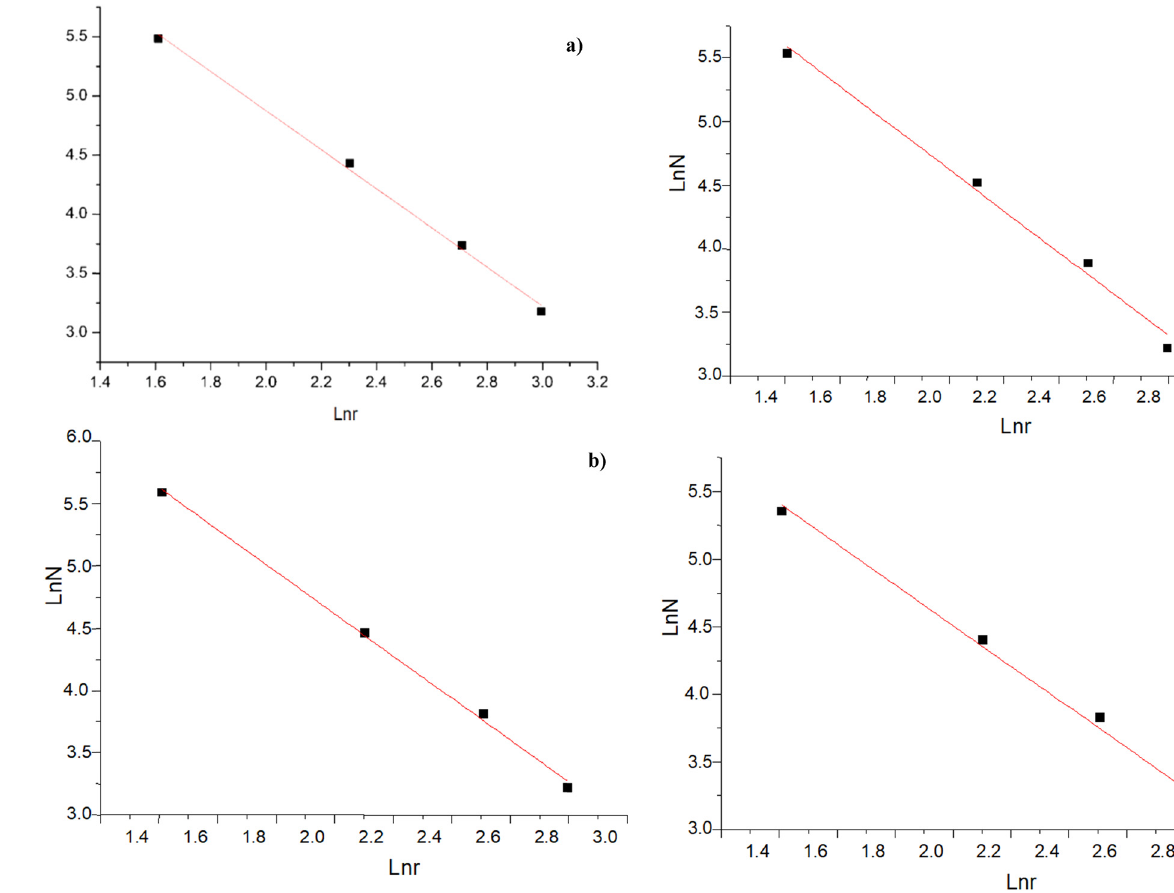
Figure 18: Double logarithmic fi tting of Type II ( a ) and Type III recycled coarse aggregate ( b ) .